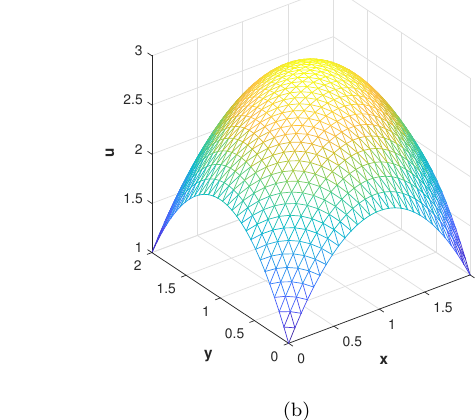
Figure 21: (a) The numerical solution at z = 1 cross section with Figure 21. ( a ) The numerical solution at z = 1 cross section with T = 0 . 01. (b) The numerical solution at z = 1 cross section with at T = 0.01. ( b ) The numerical solution at z = 1 cross section with T = 1. α = 0.9 at T =